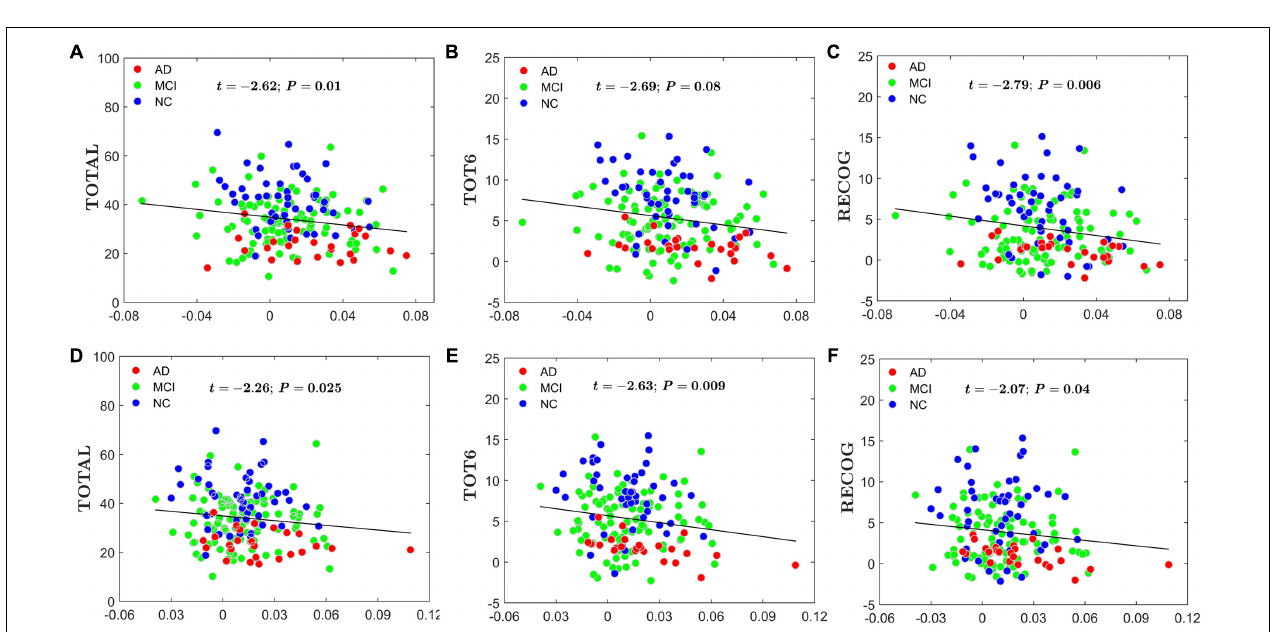
FIGURE 7 | (A) Box plot of group differences in the AI, based on the mean AI of observed significant nodes. The data were adjusted for age, gender, whole-brain ICV, hemispheric ICV differences, and TR and TE from diffusion-weighted imaging. (B) Bar charts depicting group differences in the mean nodal efficiency in each hemisphere. The data were adjusted for age, sex, hemispheric ICV, and TR and TE from diffusion-weighted imaging. P represents the P -value of GLM, and ˆP represents the Bonferroni-corrected P -value of post hoc analysis.